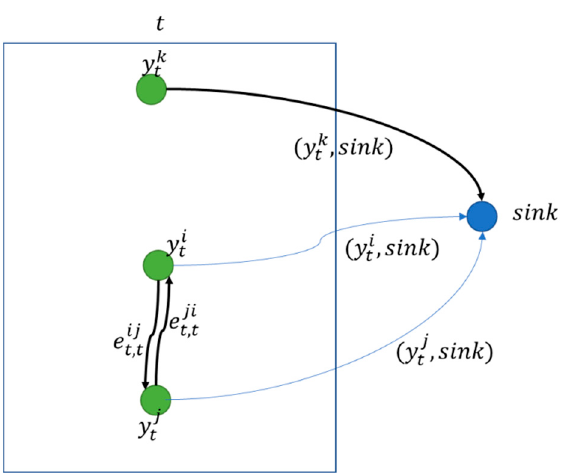
Figure 3. Illustration of a network (cid:1833)̅ (cid:3047) ((cid:1848)(cid:3364) (cid:3047) ,(cid:1827)̅ (cid:3047) ) for bucket t for the use of cut-based separation.